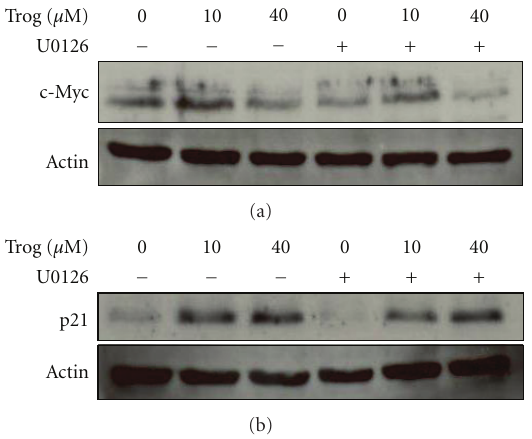
Figure 5: Combined e ff ect of U0126 and troglitazone on cell cycle protein levels in PC-3 cells. PC-3 cells were plated in DMEM/F-12 media supplemented with 10% FBS and 1% penicillin/streptomycin solution and allowed to attach. The cells were then treated for twenty-four hours with DMSO vehicle or di ff erent concentrations of troglitazone in the presence (+) or absence ( − ) of 10 μ M U0126. Western blot analysis was used to measure c-Myc, p21, and actin levels within treated